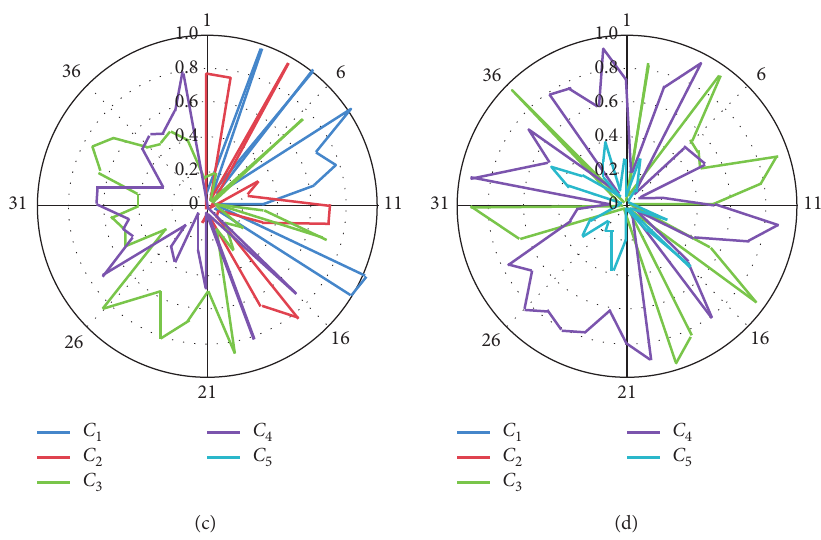
Figure 5: Measure characterization of single index. (a) PCI. (b) RQI. (c) RDI. and (d) SRI.